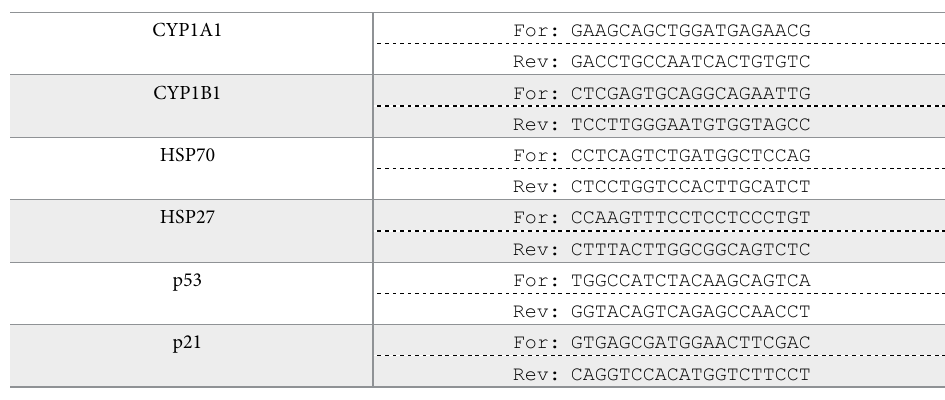
S4 Fig. (A) GPC chromatogram of PMPC (B) 1 H-NMR spectrum of PMPC